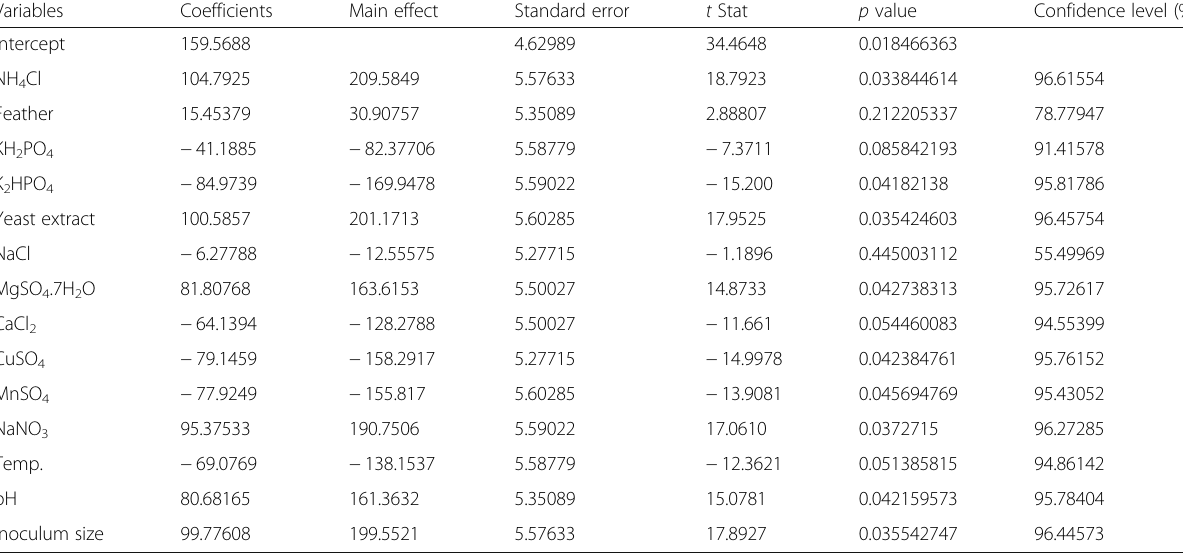
Table 2 Statistical analysis of PBD showing coefficient values, main effect, t and p values, and confidence level % for each variable affecting protease with keratinolytic activity production